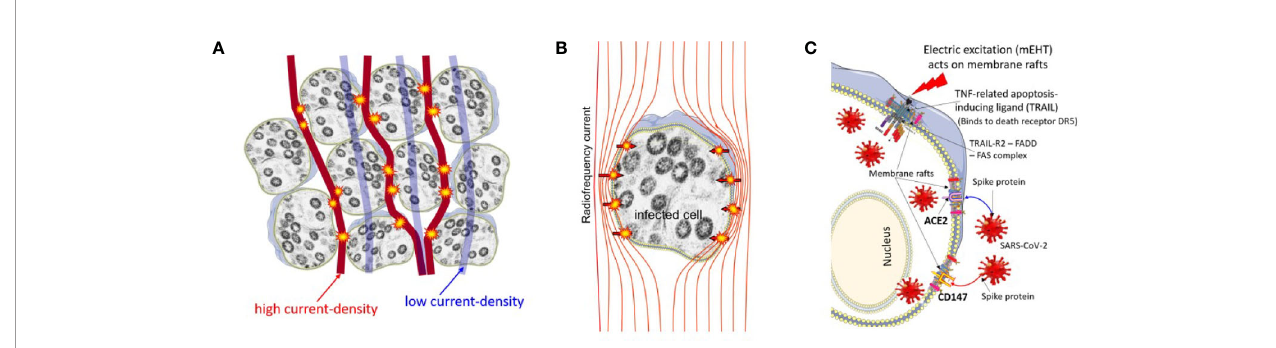
FIGURE 3 | The high current density of the applied radiofrequency power excites the rafts at the cell membrane of the infected cells, which are selected by impedance differences. (A) The current fl ows dominantly in the extracellular matrix. (B) The current (energy absorption) excites the membrane rafts. (C) The ACE2, CD147, and DR5 death receptors are involved in